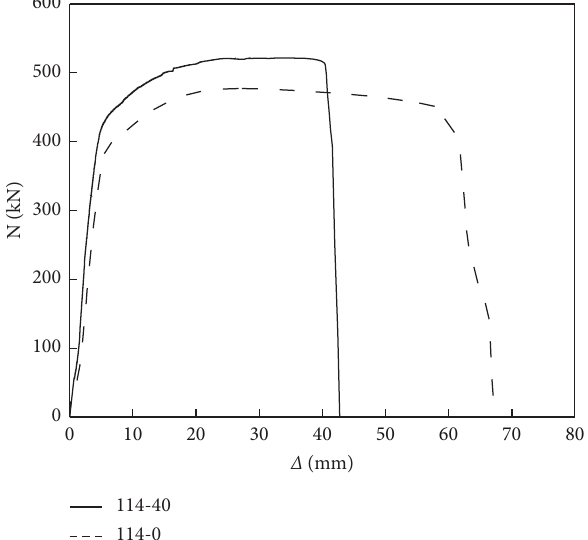
Figure 10: Load-overall displacement curve.